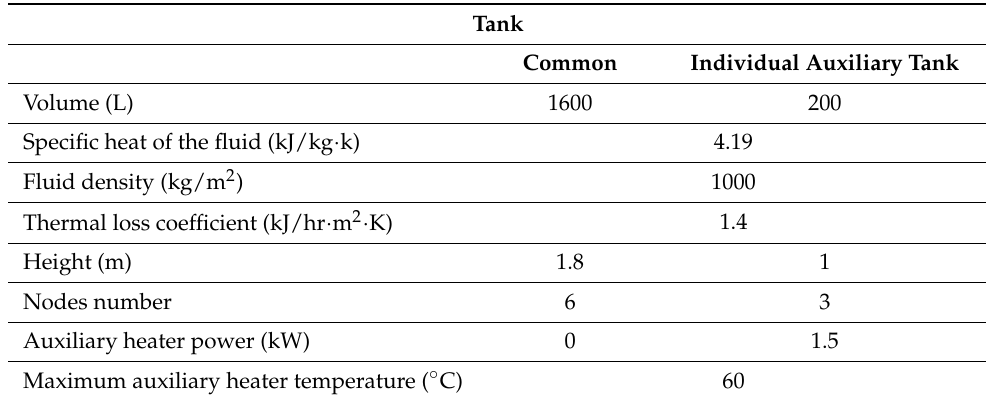
Figure 7. Simulation information flow diagram of the collective solar system. Table 8. Technical characteristic of collectors and tanks (collective